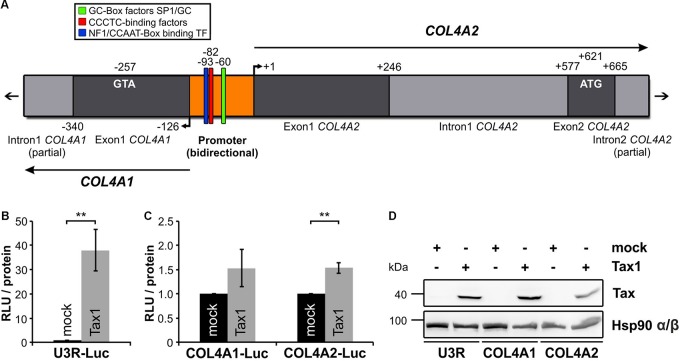
Tax transactivates the COL4A1 and COL4A2 promoter. (A) Schematic representation of the COL4A1/2 genomic organization. In the shared and bidirectional COL4A1/2 promoter region, putative genetic sites of GC-Box factors Specificity Protein 1 (SP1)/GC, CCCTC-binding factors and Nuclear Factor 1 (NF1)/CCAAT-Box binding transcription factors are indicated. Bioinformatic analysis was performed using the MatInspector software tool. (B–D) Conduction of luciferase-based reporter assays. (B,C) 5∗106 Jurkat T-cells were co-transfected with a mock (pEFneo) or Tax expression vector (pEFneo-Tax1; 30 μg DNA) together with (B) a luciferase reporter vector for the U3R promoter from the HTLV-1 5′LTR region (U3R-Luc; 20 μg DNA) as a positive control, or (C) luciferase reporter vectors specific for the COL4A1 or COL4A2 promoter region (COL4A1-Luc, COL4A2-Luc; 20 μg DNA). Values were normalized on protein content and the luciferase background activity measured by co-expression of a promoter-less luciferase vector (pGL3-Basic). The mean of five independent experiments ± SE is depicted and Student’s t-test was performed (∗∗p < 0.01) comparing the different reporter vectors with their respective mock control. (D) Immunoblot staining of Tax and Hsp90 α/β protein served as expression control.